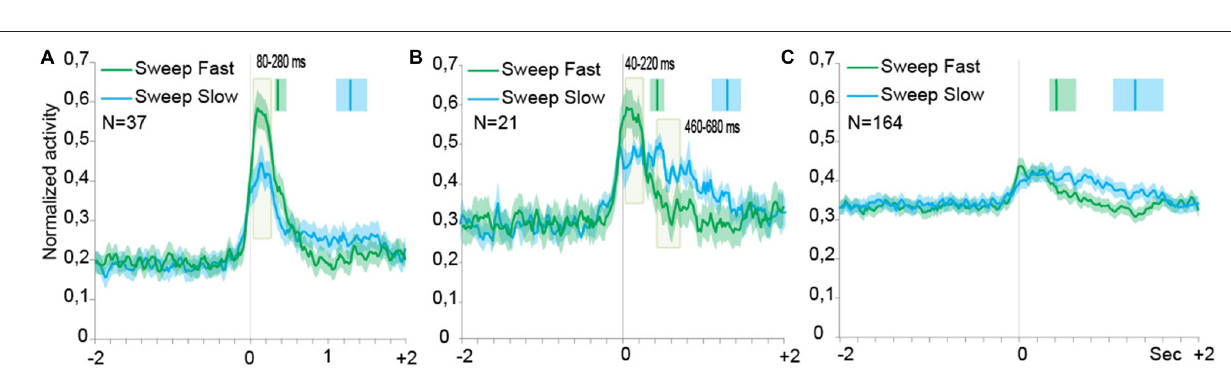
FIGURE 4 | Time course of the activity of neuronal populations aligned (gray line) on the tactile stimulation onset in the both conditions, Sweep Fast and Sweep Slow. Green lines indicate the time course of activity during Sweep Fast, while blue lines represent the time course of activity during Sweep Slow. On the Y axis is represented the normalized activity of the neuronal populations, while on the X axis is represented the time (sec). (A) The population of the SS neurons is activated stronger during the Sweep Fast compared with the Sweep Slow, in particular from 80 ms after alignment to 280 ms. (B) The population of the SU neurons showing correlation between the speed of stimulation and firing rate. From 40 ms after the alignment to 220 ms, the population is activated stronger during the Sweep Fast than Sweep Slow, while from 460 to 680 ms the activity is higher during the Sweep Slow than during the Sweep Fast. (C) The population of the SU neurons that did not show correlation between the speed of sweeping and the firing rate. The population does not discriminate between the speed of stimulation and the two tasks do not differ from each other. In (A–C) the activity is in alignment when the experimenter touched the monkey’s body. The median times of the end of sweep fast and sweep slow are indicated with the green and blue markers, respectively, above each population plot. Shaded areas around each marker represent the 25th and 75th percentile times. In (A,B) the light green shaded regions indicate the period in which the paired samples t -tests evidence a significant separation of the two curves ( p <